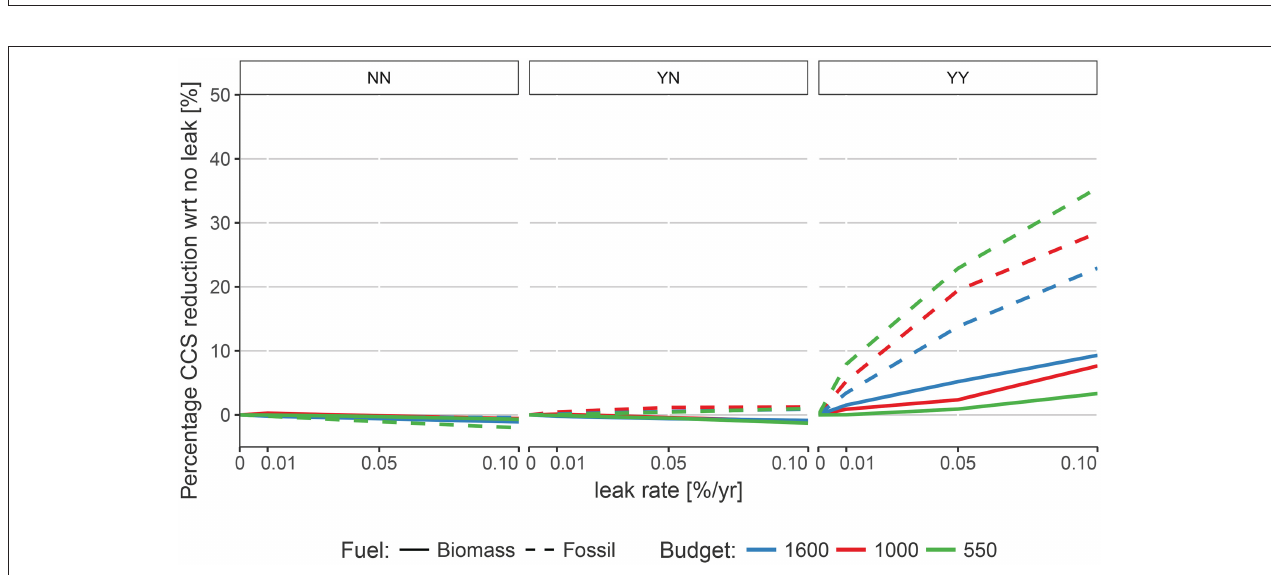
FIGURE 4 | Capacity reduction in CCS compared to no leakage case [%]. The reference values of total installed capacity by 2100 in case of zero leakage are: 61 TW (biomass) and 52 TW (fossil) for the 1,600 scenario, 63 TW (bio) and 37 TW (fossil) for 1,000 GtCO 2 and 75 TW (bio) and 25 TW (fossil) in the 550 GtCO 2 case.